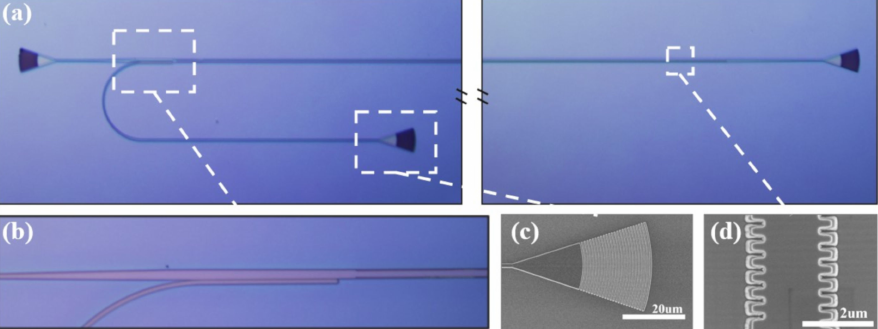
Figure 4. ( a ) Microscope image of the demonstrated mode-conversion-based CBG. ( b ) Close-up of the ADC. SEM image of the grating coupler ( c ) and Bragg grating ( d